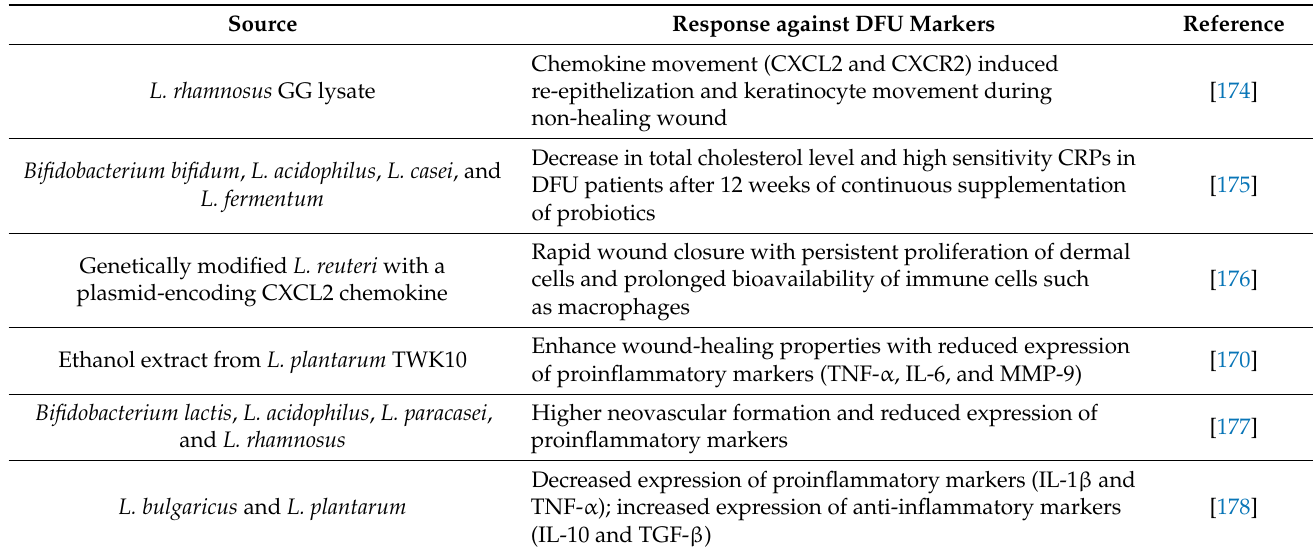
Table 3. Probiotic responses against DFU